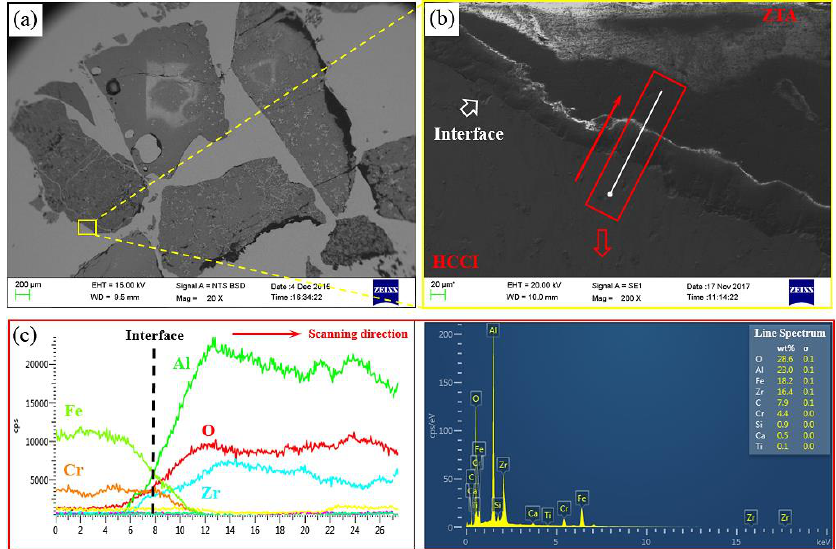
Figure 3. ( a ) Particle distribution; ( b ) Interfacial bonding state; ( c ) EDS (energy dispersive spectrometer) line scan analysis and results across the interface.